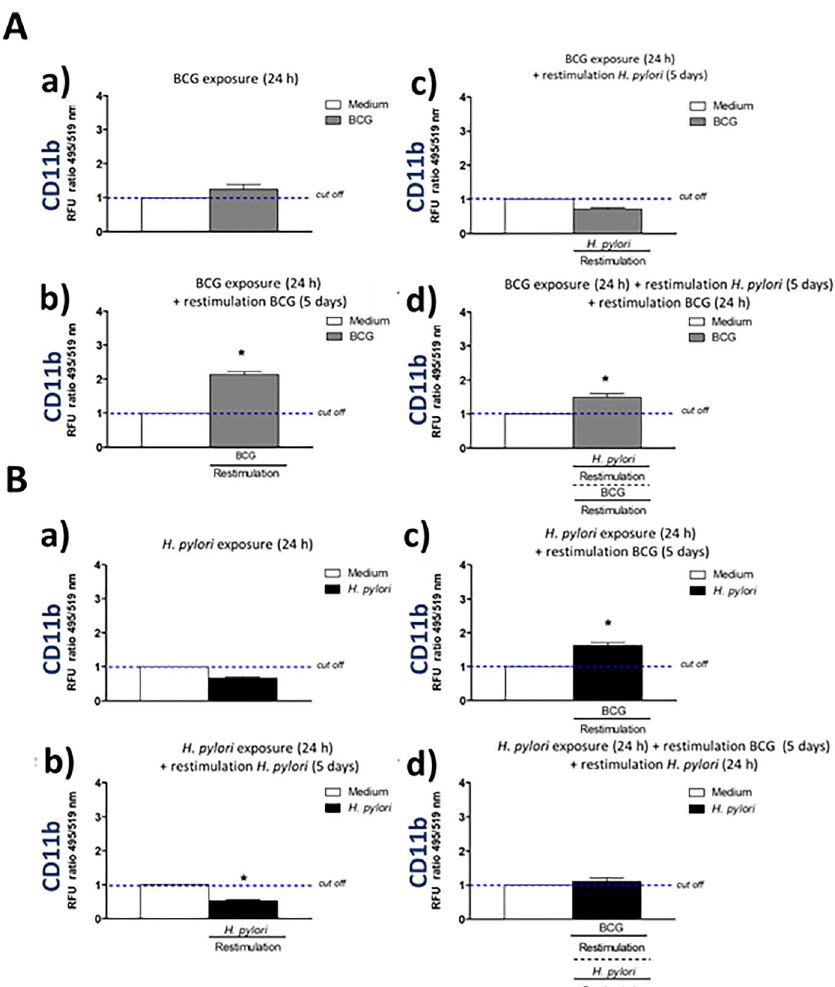
Figure 3. Positive modulation of CD11b expression in THP-1 macrophages by M. bovis BCG. Cells were primed with M. bovis BCG or H. pylori and then they underwent restimulation with homologous or heterologous microbial agent. THP-1 macrophages primed with M. bovis BCG ( A ): cells primed for 24 h with M. bovis BCG (a); cells primed for 24 h with M. bovis BCG and restimulated for 5 days with M. bovis BCG (b); cells primed for 24 h with M. bovis BCG and restimulated for 5 days with H. pylori (c); cells primed for 24 h with M. bovis BCG then restimulated for 5 days with H. pylori and for an additional 24 h with M. bovis BCG (d). THP-1 macrophages primed with H. pylori ( B ): cells primed for 24 h with H. pylori (a); cells primed for 24 h with H. pylori and restimulated for 5 days with H. pylori (b); cells primed for 24 h with H. pylori and restimulated for 5 days with M. bovis BCG (c); cells primed for 24 h with H. pylori , restimulated for 5 days with M. bovis BCG and an additional 24 h with H. pylori (d). The above variants of cells were stained using the fluorescently labeled specific anti-CD11b antibodies. Results are presented as median fluorescence units (RFU) ratio ± range of three independent experiments. The difference statistically significant when p < 0.05 in Mann– Whitney U . *Cells stimulated versus unstimulated (according to the time of stimulation). BCG or H. pylori MOI